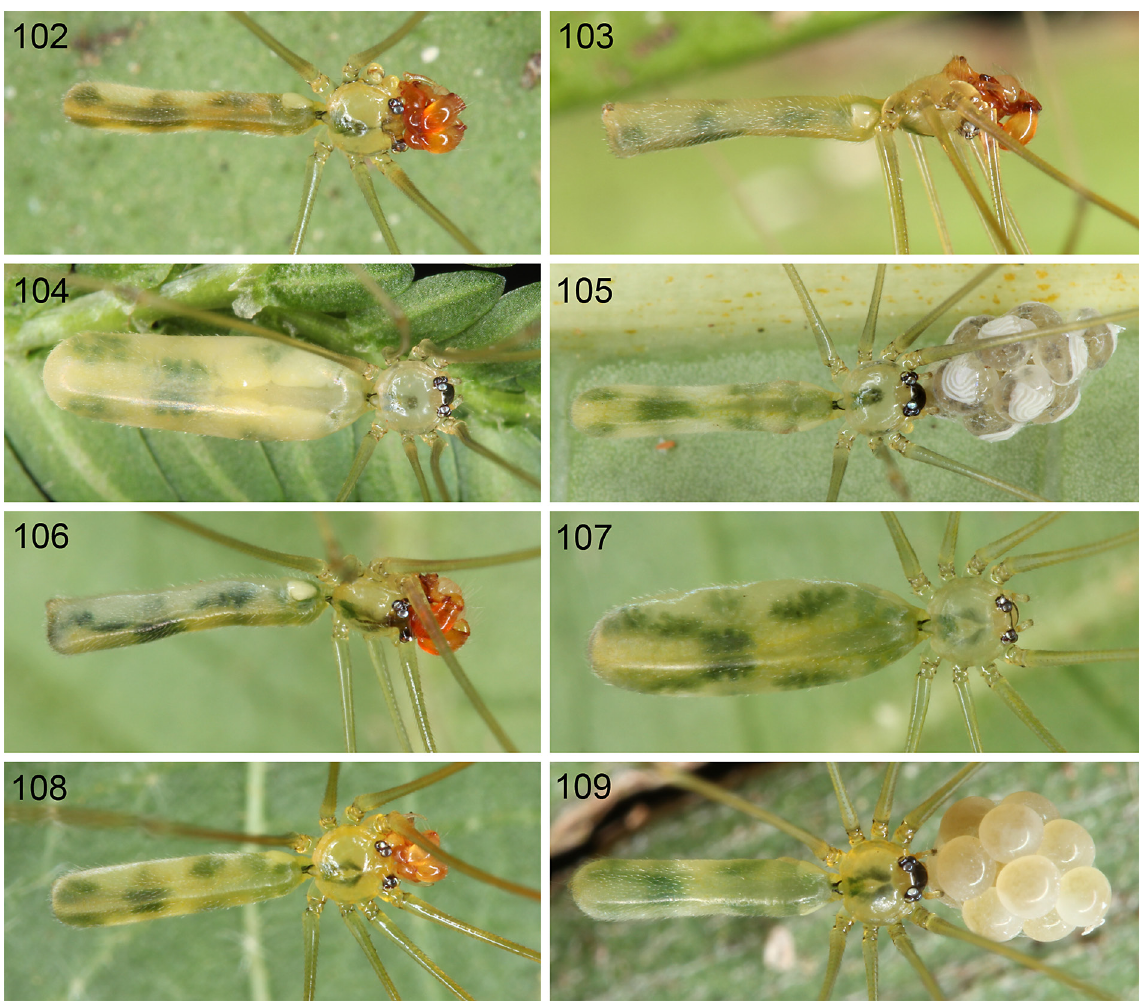
Figs 102–109. Live specimens, Pholcus krabi Huber, sp. nov. (102–105), Ph. narathiwat Huber, sp. nov. (106–107), and Ph. kipungit Huber, sp. nov. (108–109). 102–104 . ♂ and ♀ from Khao Sok, Thailand. 105 . ♀ with egg-sac from Phanom Bencha, Thailand. 106–107 . ♂ and ♀ from Hala Bala, Thailand. 108–109 . ♂ and ♀ from Poring,